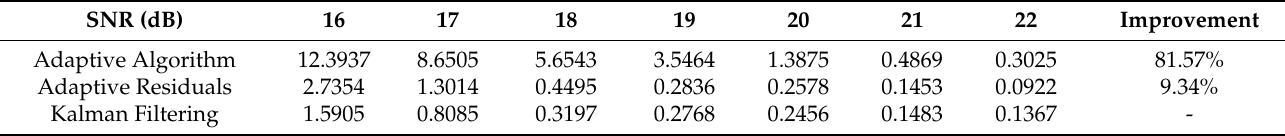
Figure 8. Positioning accuracy comparison of different methods with different SNR values. Table 3. The positioning accuracy of the three methods with the traditional